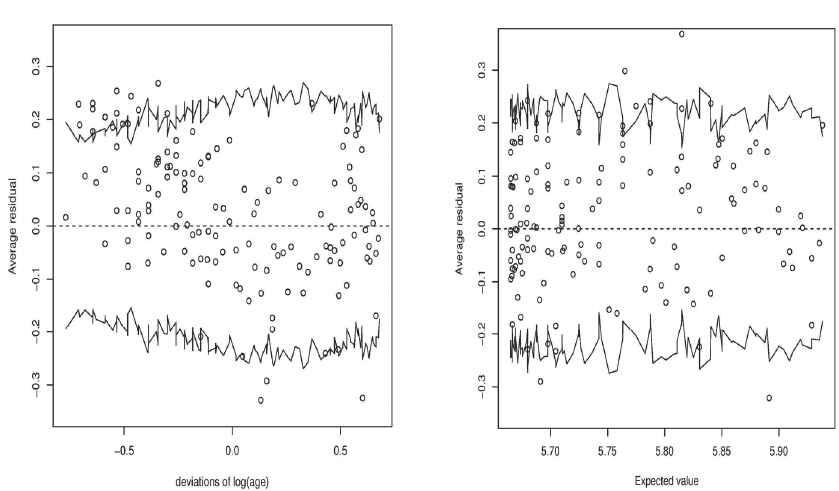
Figure 2 – Binned residuals for (cid:91) (cid:3) parameter vs average of Age and expected